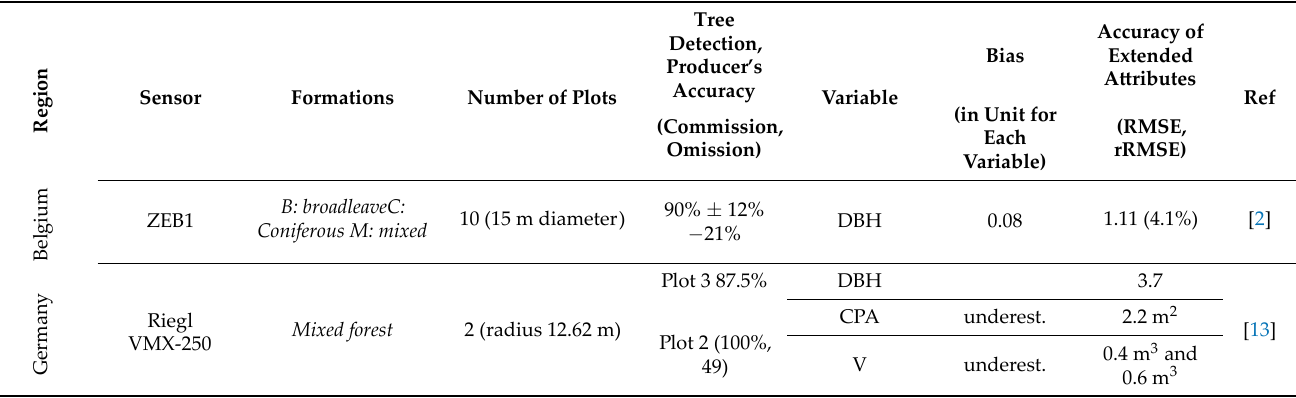
Table A1. Summary results of HLS‑based forest inventory